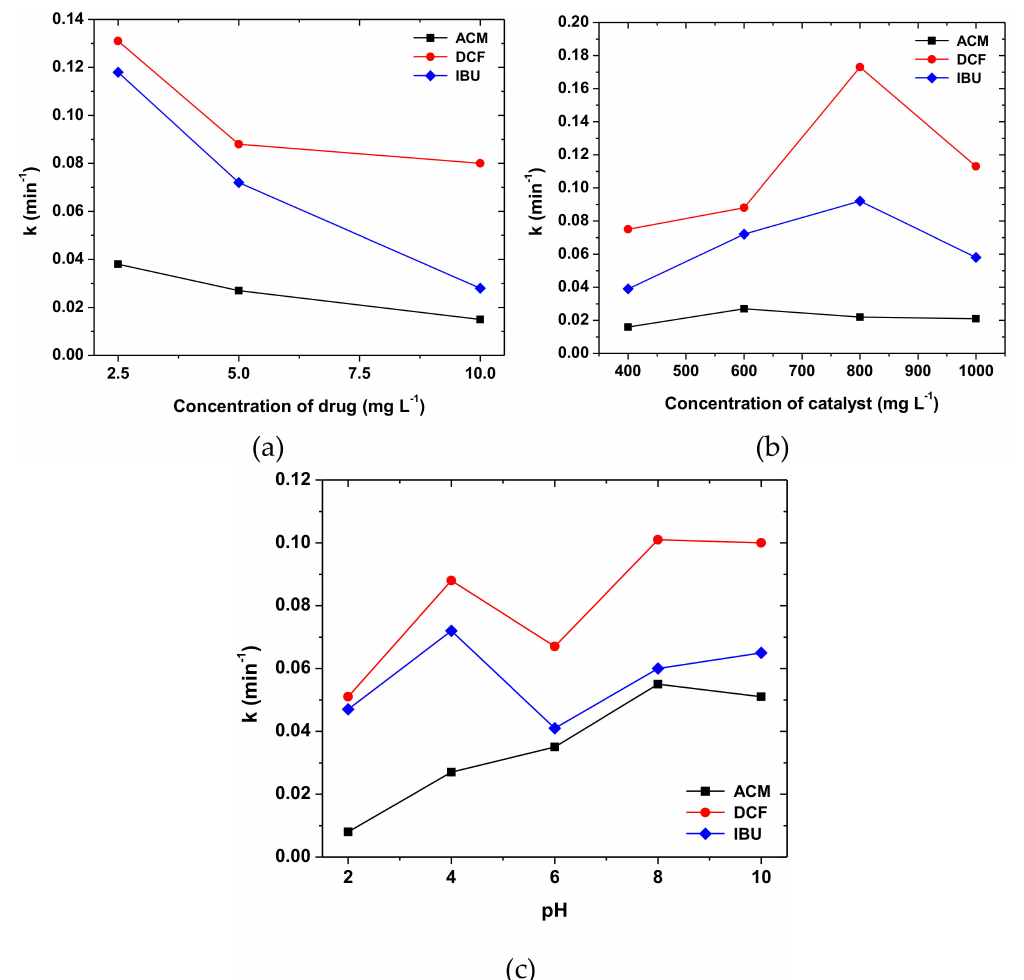
Figure 6. The effect of operational parameters on degradation kinetic rate (k) of anti-inflammatory drug mixture, ( a ) effect of mixture concentration (C(PEF/TiO 2 20 wt% = 600 mg L − 1 ); ( b ) effect of catalyst loading (C o (drug) = 5 mg L − 1 ); and ( c ) effect of pH, during photocatalytic treatment (C o (drug) = 5 mg L − 1 , C((PEF/TiO 2 20wt %) = 600 mg L − 1